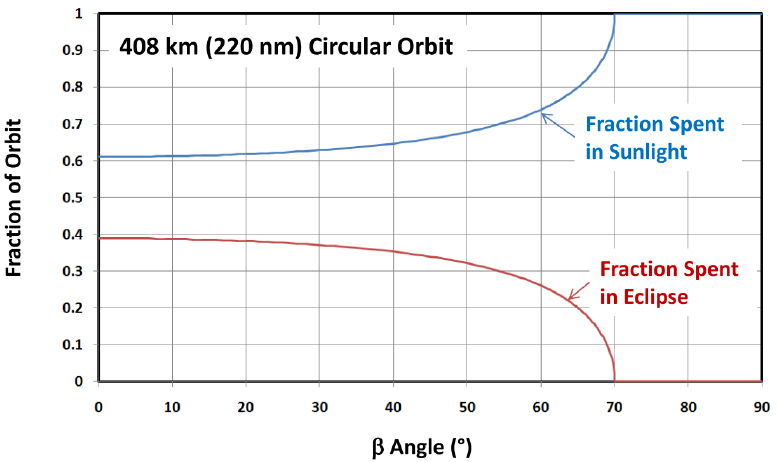
Figure 12. Fraction of time spent in sunlit and